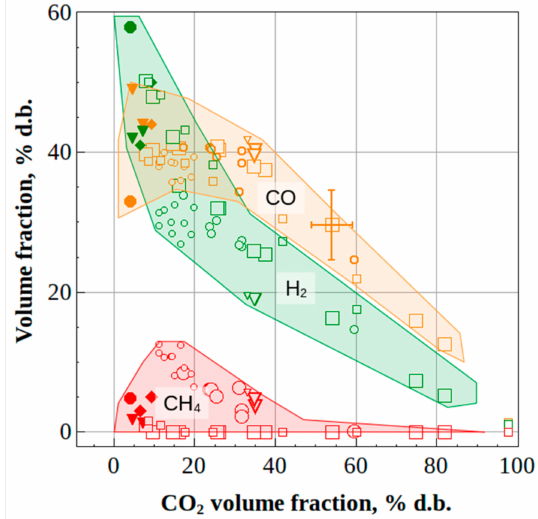
Figure 10. Comparison of syngas compositions in experiments on natural gas conversion (squares), and liquid (circles) and solid (triangles) waste gasification at f = 1 Hz and P ≈ 0.1 MPa. Large empty symbols correspond to the 100-dm 3 reactor, small empty symbols correspond to the 40-dm 3 reactor, large filled symbols correspond to plasma reactors [19,22], diamonds correspond to RDF gasification